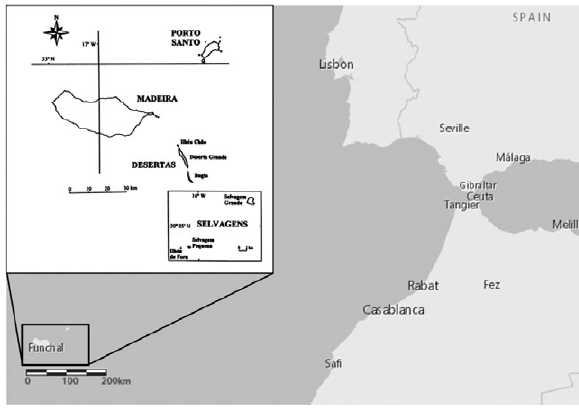
Fig. 1. – Map showing the Madeira Autonomous Region